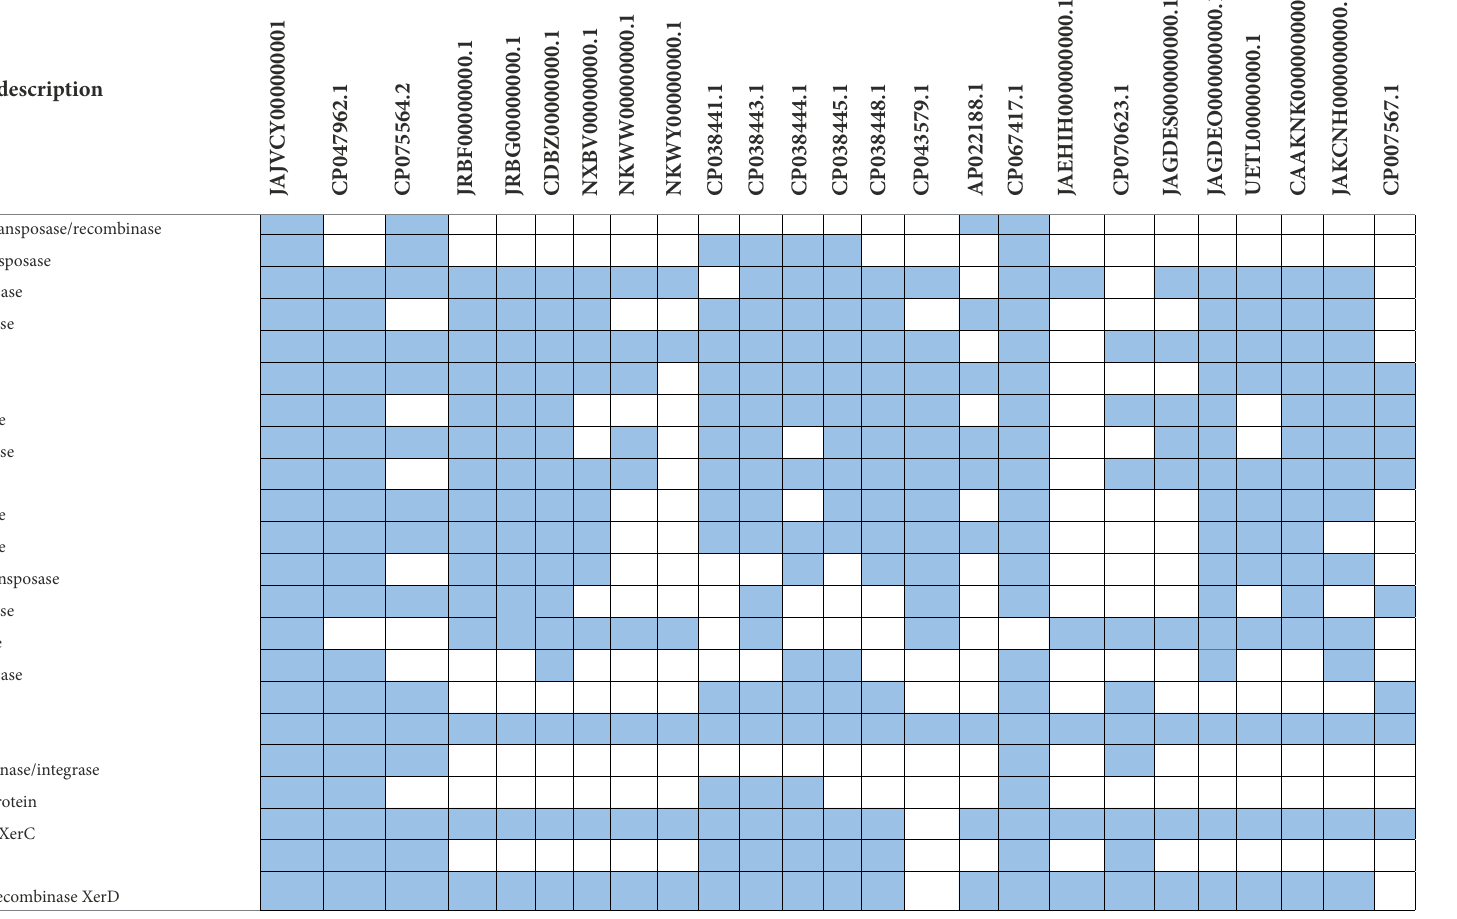
TABLE 5 Transposes, integrases and recombinases detected in the Aeromonas media genomes.